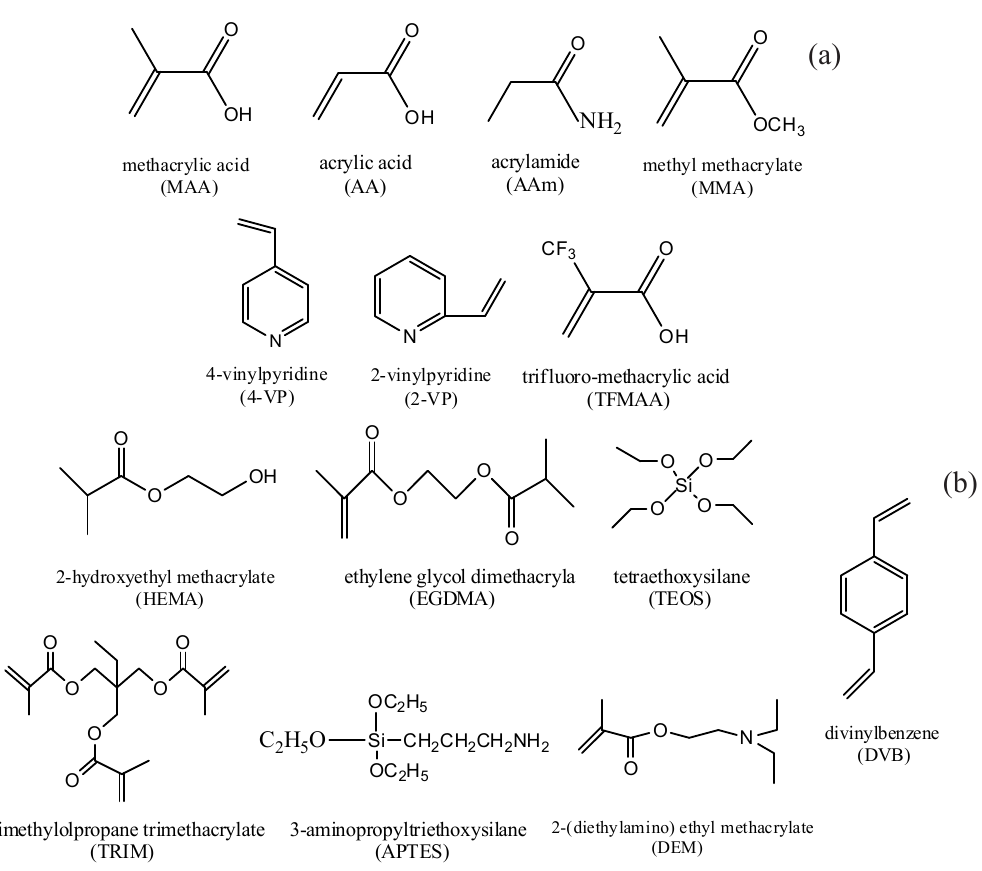
Figure 1. List of the most frequently used functional monomers (A) and cross-linkers (B) in MIP synthesis, including their chemical structures.